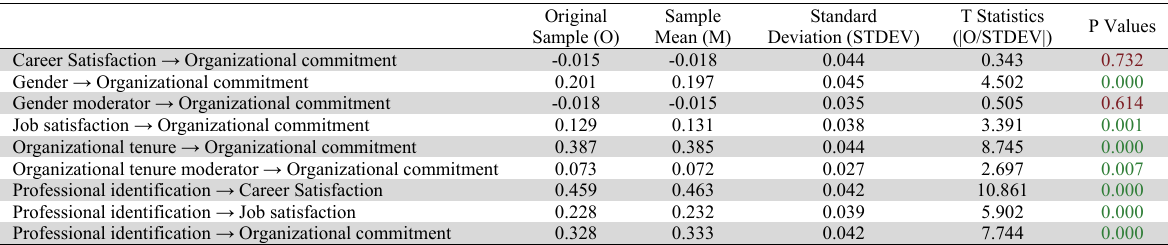
Path Coefficients of moderate variables